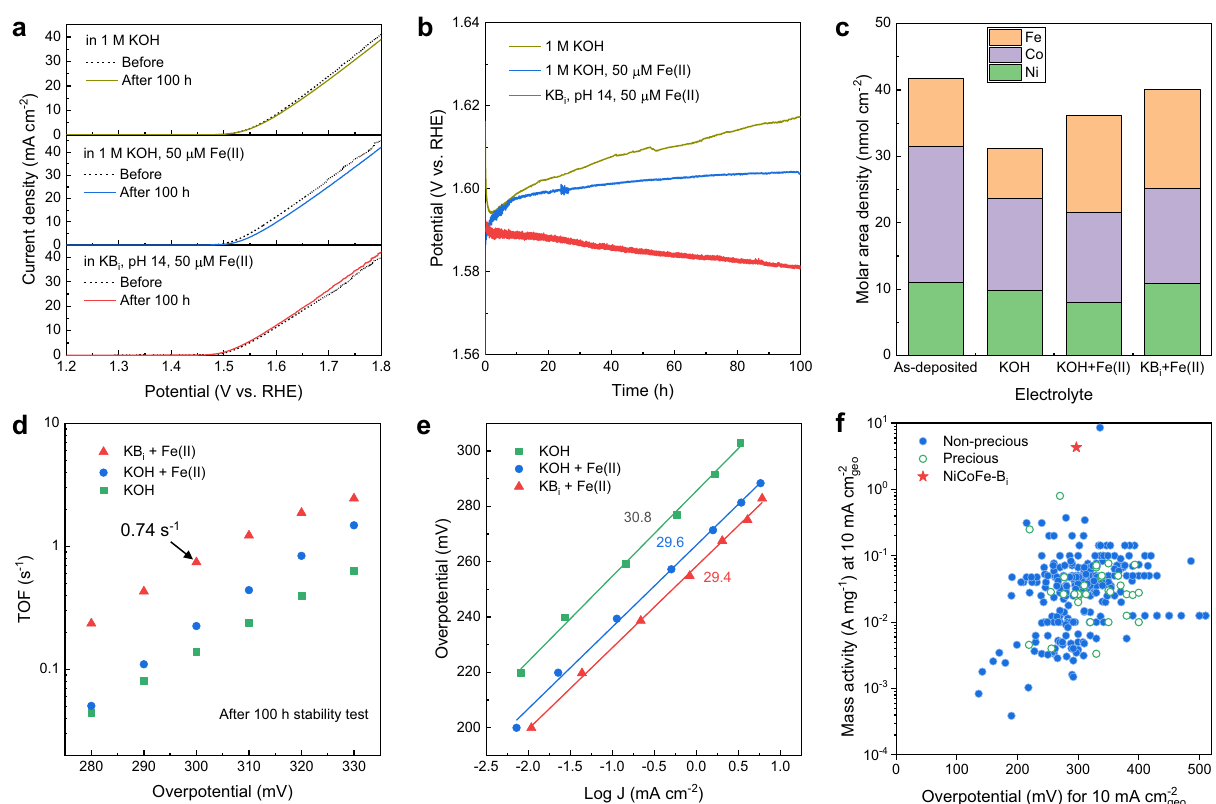
Fig. 3 Self-healing and intrinsic catalytic properties of the NiCoFe-B i catalyst deposited on FTO substrate. a The OER polarization curves of NiCoFe-B i catalysts before and after stability testing for 100 h in different electrolytes. The curves were measured at 1 mV s − 1 scan rate, without iR correction. b Chronopotentiometric curves of NiCoFe-B i catalysts measured at constant current density of 10 mA cm − 2 for 100 h in different electrolytes. c Quantitative ICP-MS analysis of the NiCoFe-B i catalysts before and after the 100 h stability tests in different electrolytes. d The oxygen evolution TOF of the NiCoFe-B i catalyst in different electrolytes. The values were calculated using polarization curves and ICP-MS data measured after the 100 h stability test. e Tafel plots of the NiCoFe-B i catalyst in different electrolytes. f Comparison of the mass activity of our NiCoFe-B i catalyst with literature-reported values 40